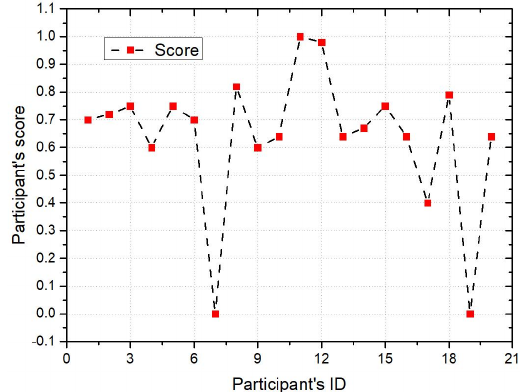
Figure 4. Reward reference value.